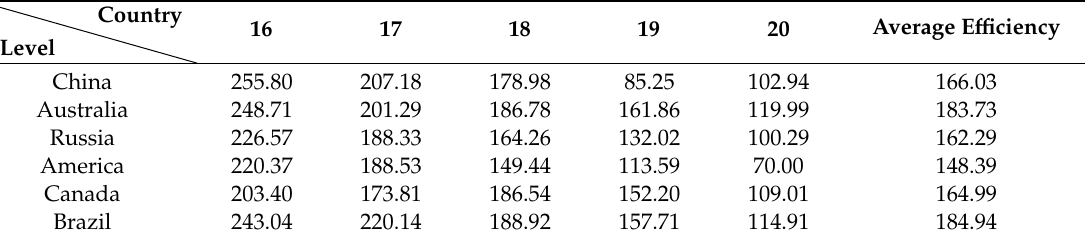
Table 5. Discretization e ffi ciency (number of cells rasterized ms − 1 ) of the spherical vector lines using traditional spherical geometry